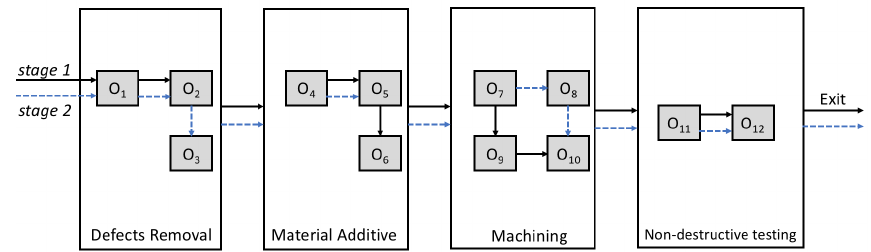
Figure 4. Re-manufacturing process example for two batches of turbine